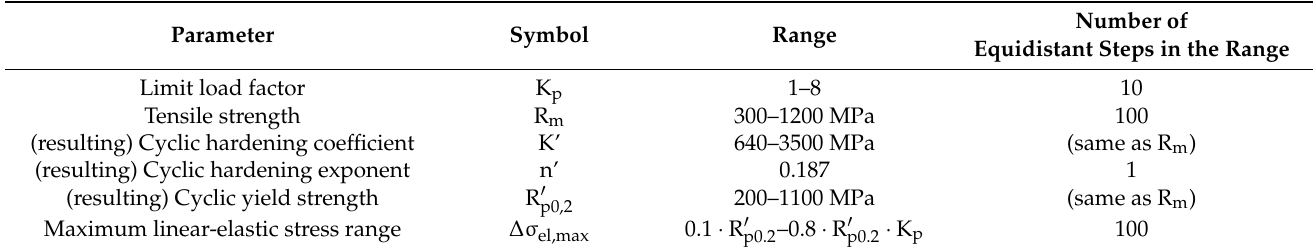
Table 2. Investigated parameter space for the applicability and performance of the notch approximation with different termination criteria when using Newton’s